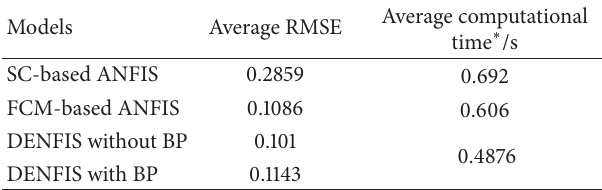
Table 3: Test performance of the NF models